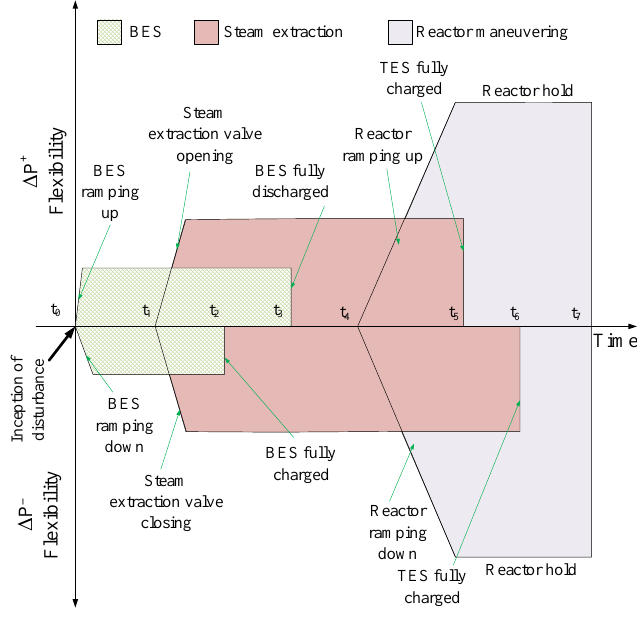
Figure 5. Asset activation during NO and corresponding flexibility